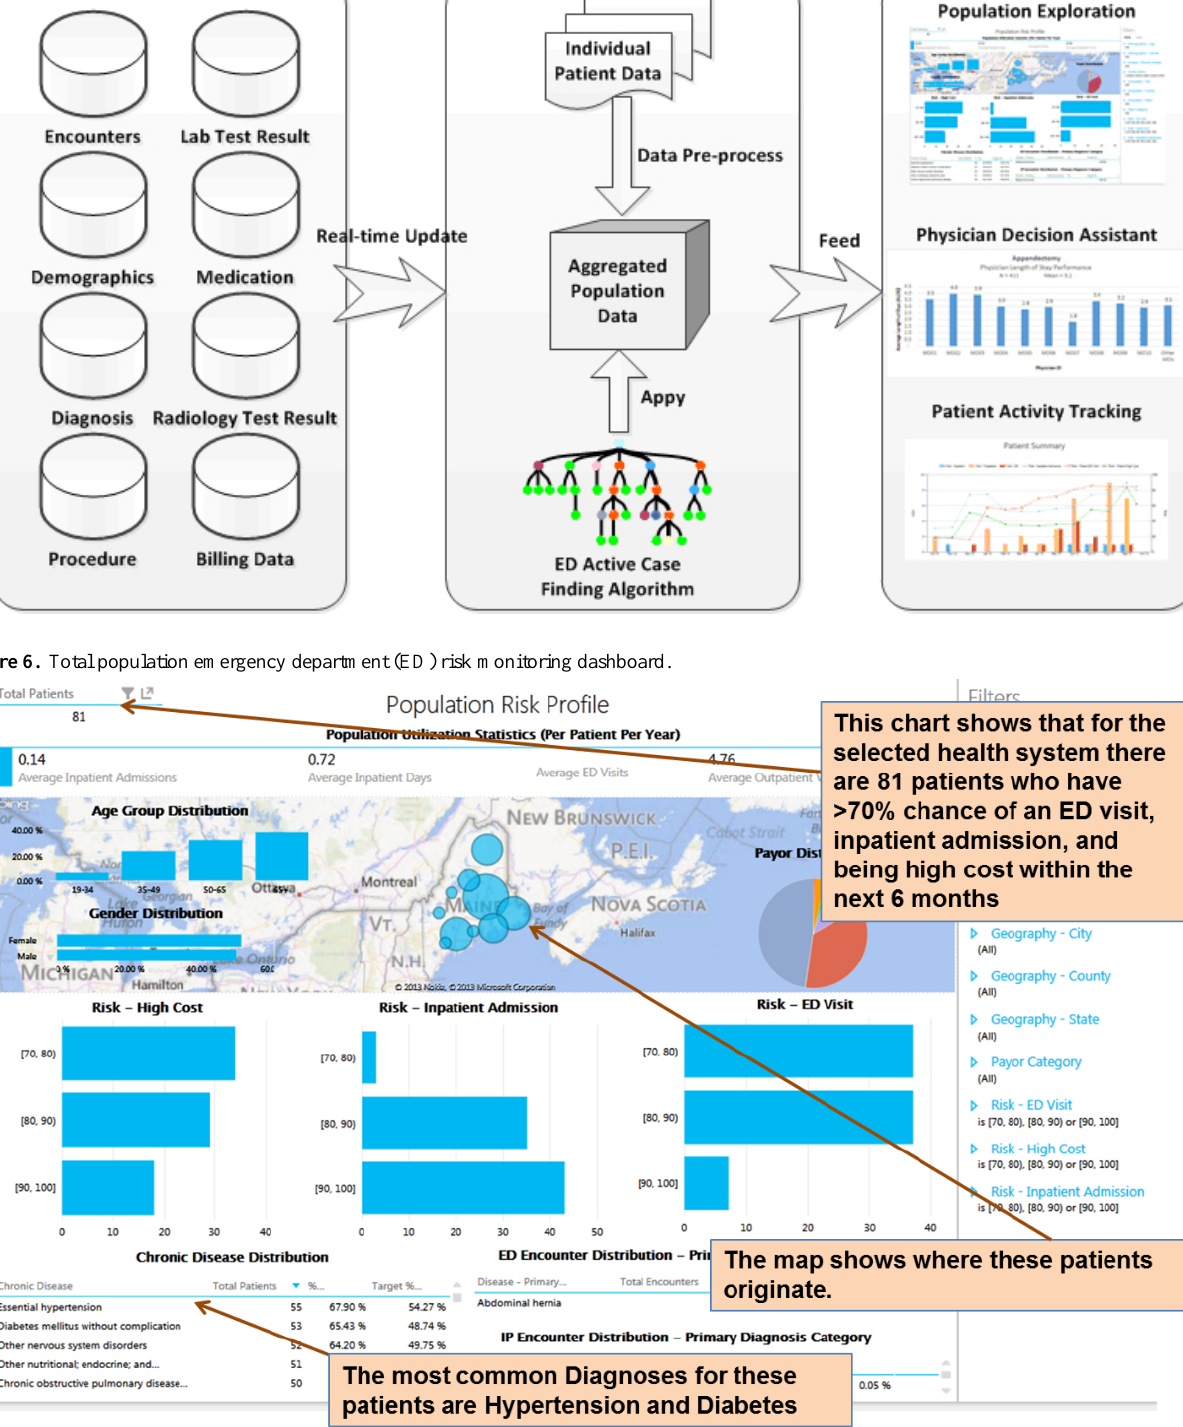
Figure 5. Schematic demonstration of data flow and communications of a population emergency department (ED) risk exploration system that allows real-time assessment of population ED risk.